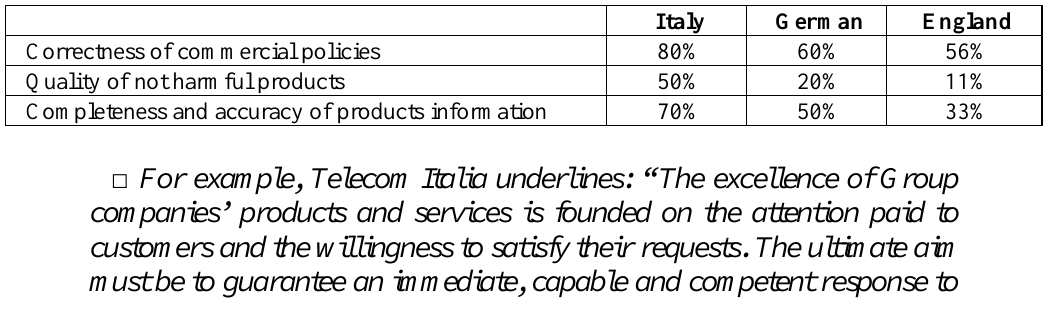
Table 7: Standard Behaviour in Relationship with Customers and